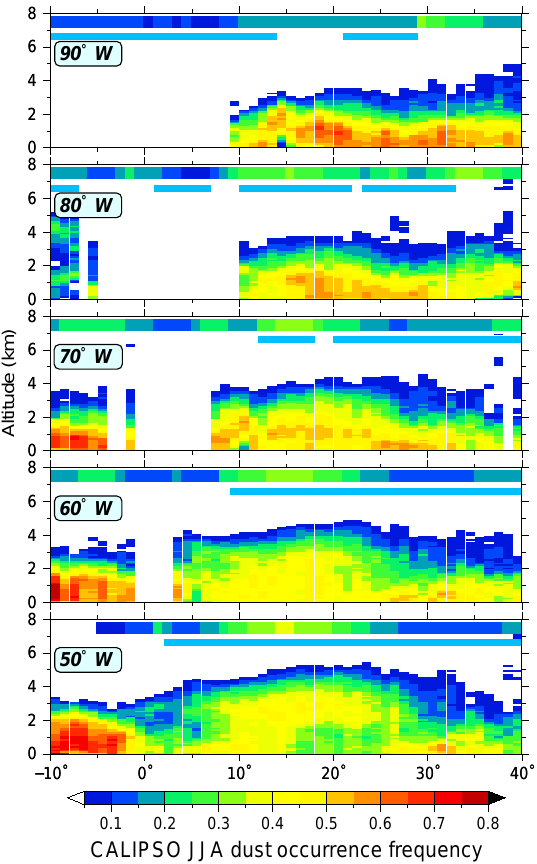
Fig. 5. Same as Fig. 3 but only for summer (JJA) at the five longitudes: 50 ◦ W, 60 ◦ W, 70 ◦ W, 80 ◦ W and 90 ◦ W. The cross section at 50 ◦ W is repeated in order to facilitate the inspection of SAL evolution.